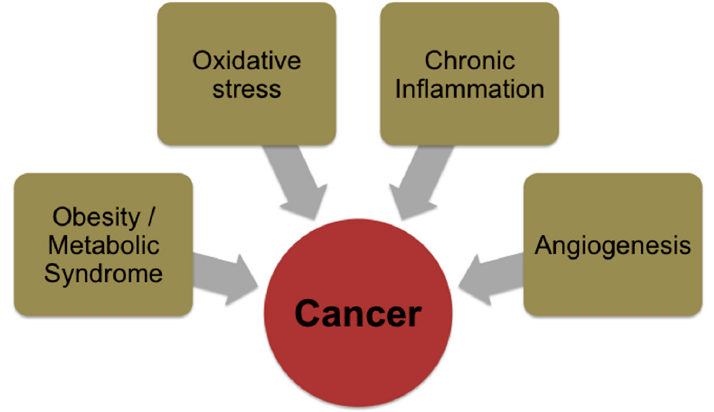
Figure 2. Major nutrition/diet-related factors/stressors that can contribute to cancer.